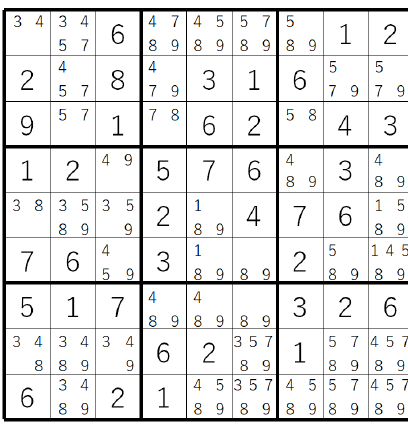
Figure 4. Grid showing that locked candidates are independent of the combination of naked singles and hidden